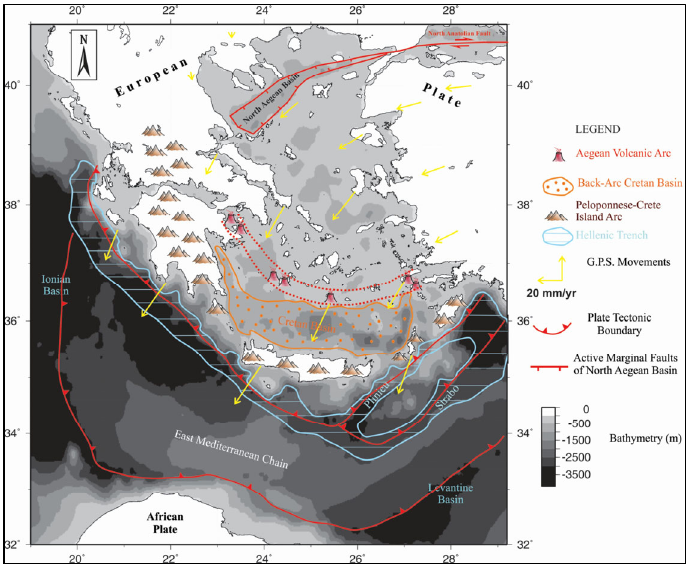
Figure 2. Geotectonic setting of the Hellenic Volcanic Arc (modified from [27]).